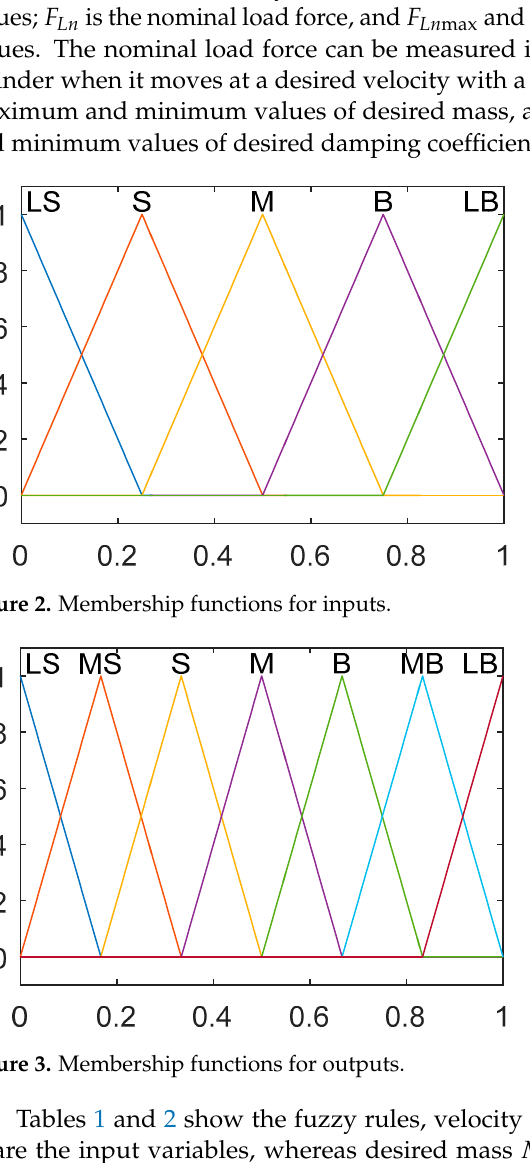
LS Table 2. Fuzzy rules of desired damping coefficient B . B